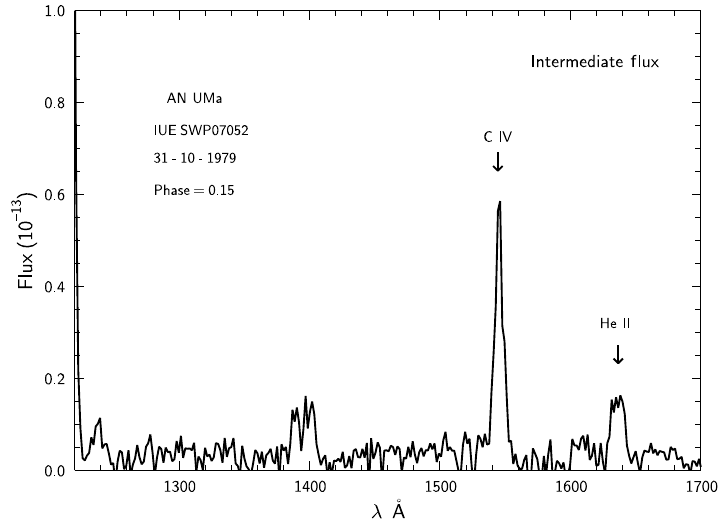
Fig. 3. IUE spectrum of AN UMa with intermediate (cid:13)ux at phase 0.15. The (cid:13)ux is plotted in units of erg cm (cid:0) 2 s (cid:0) 1 (cid:23)A (cid:0) 1 .